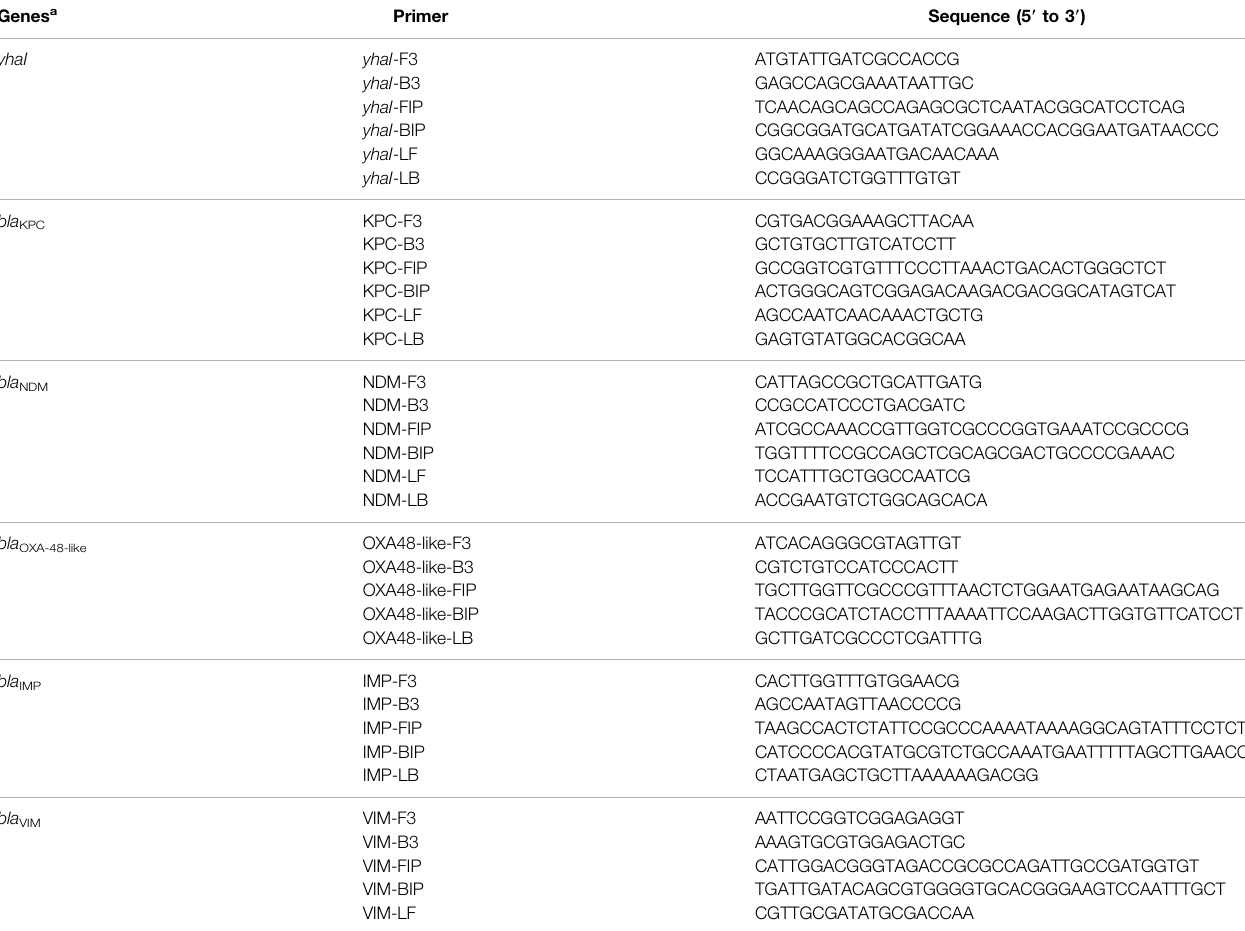
TABLE 1 | LAMP primer sets designed for this study, targeting the K. pneumoniae Inner membrane protein ( yhaI ) and carbapenemase genes ( bla KPC , bla NDM , bla OXA-48-like , bla IMP , and bla VIM